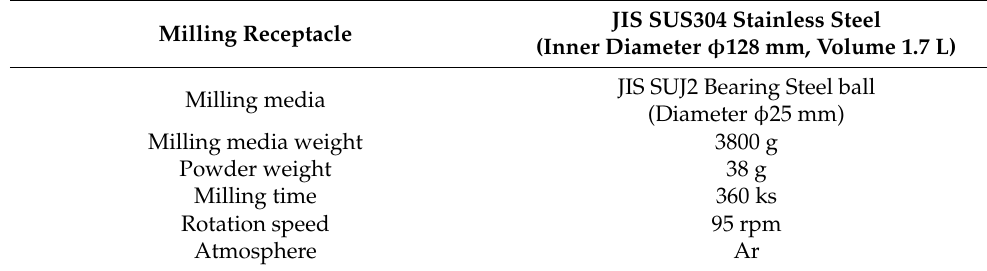
Table 1. Conditions of mechanical ball milling (MM) performed in this study. Milling